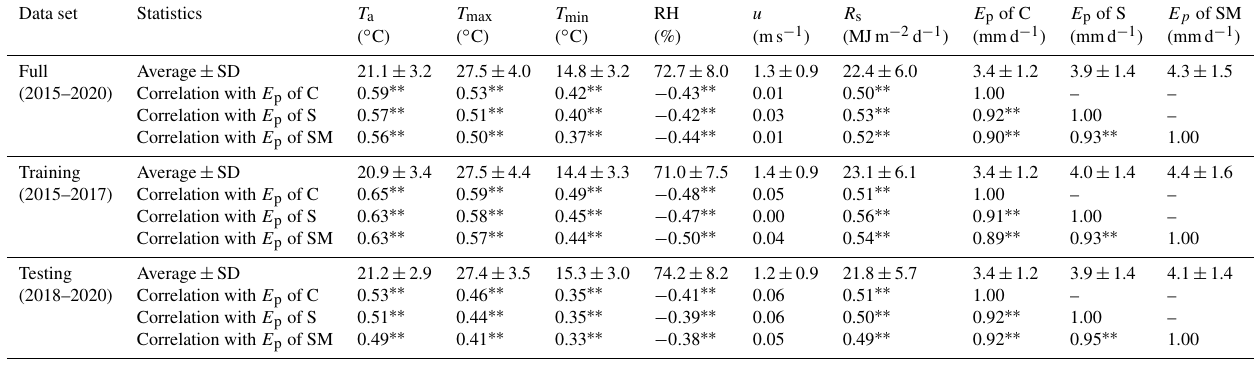
Table 2. Statistics of meteorological variables ( T a – mean air temperature, T max – maximum air temperature, T min – minimum air temper- ature, RH – relative humidity, R s – solar radiation, u – wind speed) and their correlation with evaporation ( E p ) of C, S, and SM in the full cover–bottom, and A pan with planted freshwater submerged macrophyte, respectively.